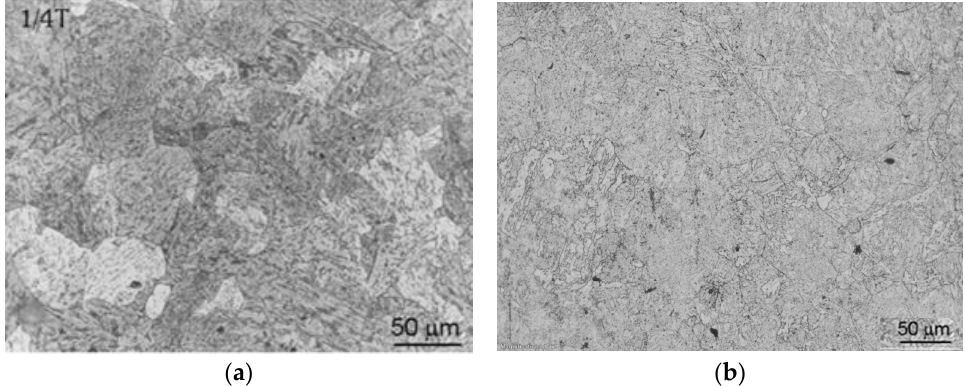
Figure 1. Optical microscopy performed in etched condition to observe the grain boundaries on an A508 CL.2 ( a ) and on an 15Kh2NMFA ( b ) sample. A508 CL.2 ( a ) and on an 15Kh2NMFA ( b )